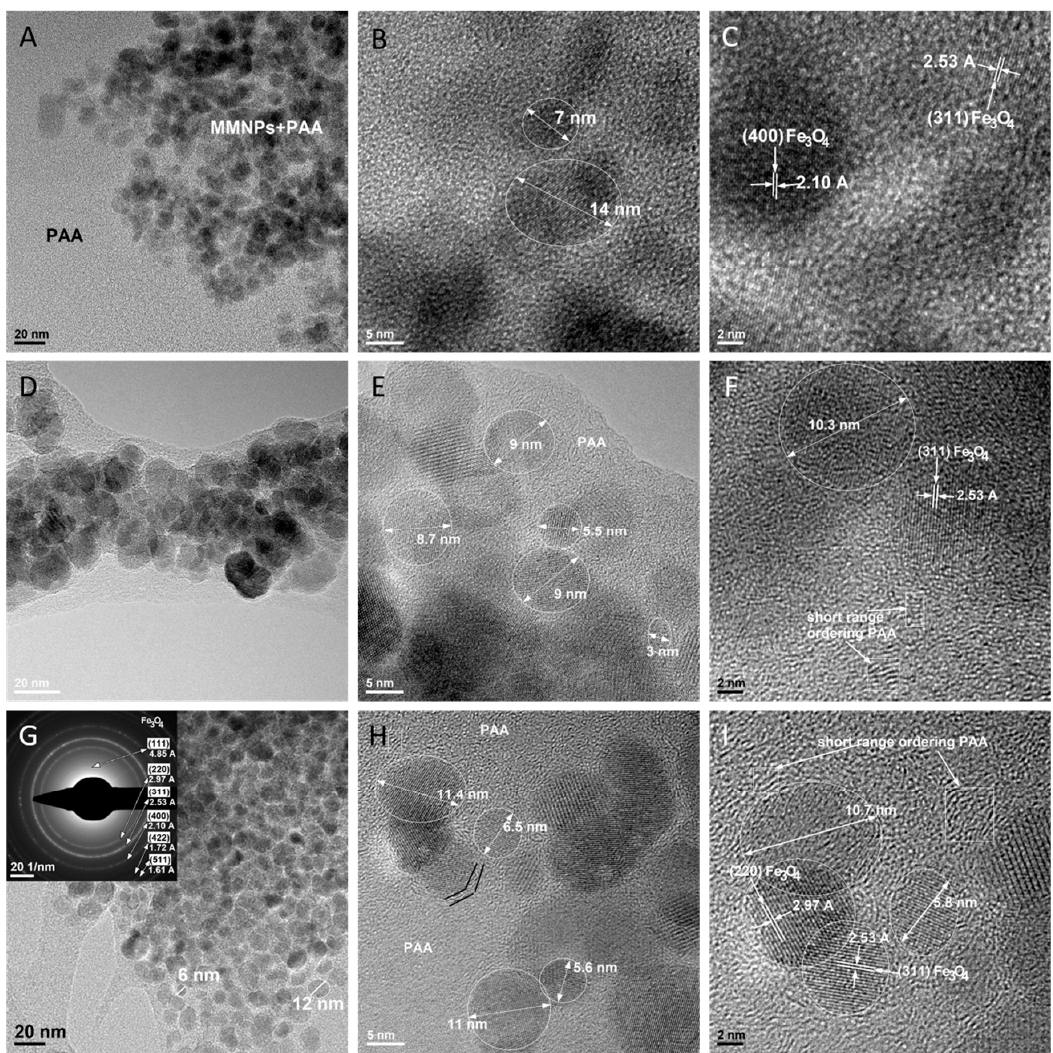
Figure 11. Bright field (BF)-TEM and HR-TEM images on PAA-MMNPs 90:10 ( A–C ); PAA-MMNPs 70:30 ( D–F ) and on PAA-MMNPs 50:50 ( G–I ).